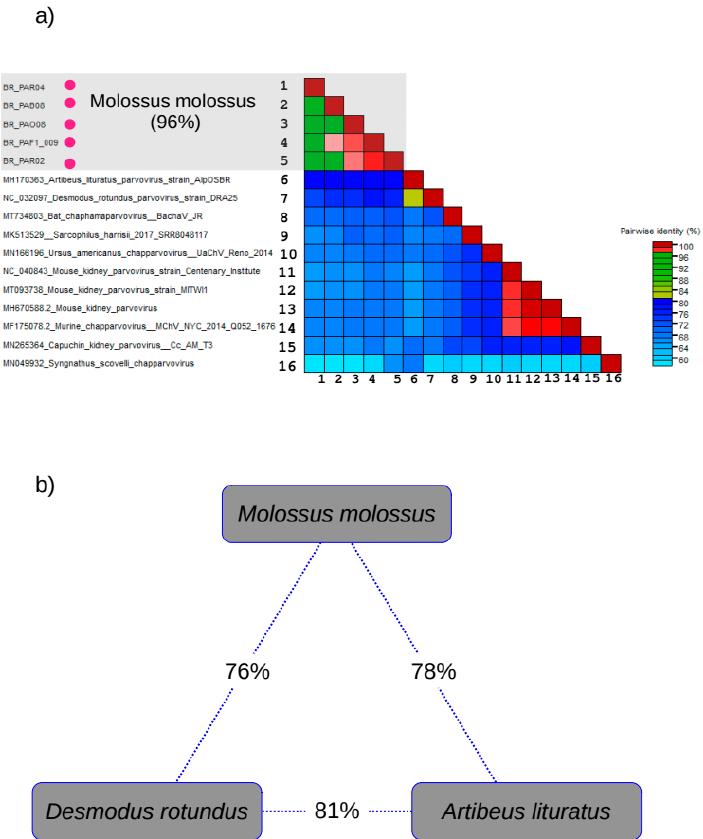
Figure 6. Nucleotide identity of NS1 of CHPV. ( a ) Identity matrix showing pairwise comparisons among distinct CHPV sequences. ( b ) Chart depicting the pairwise identity of NS1 gene in CHPV identified in Brazilian bats.